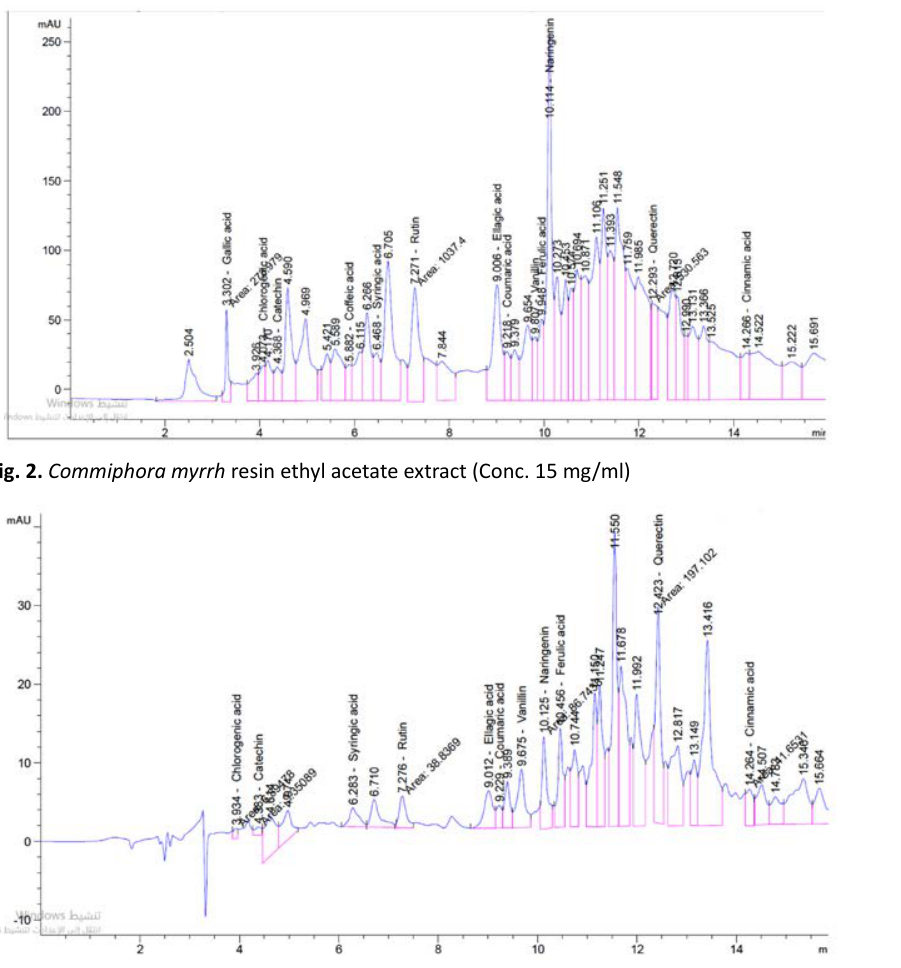
Fig. 3. Commiphora myrrh resin petroleum ether extract (Conc. 15